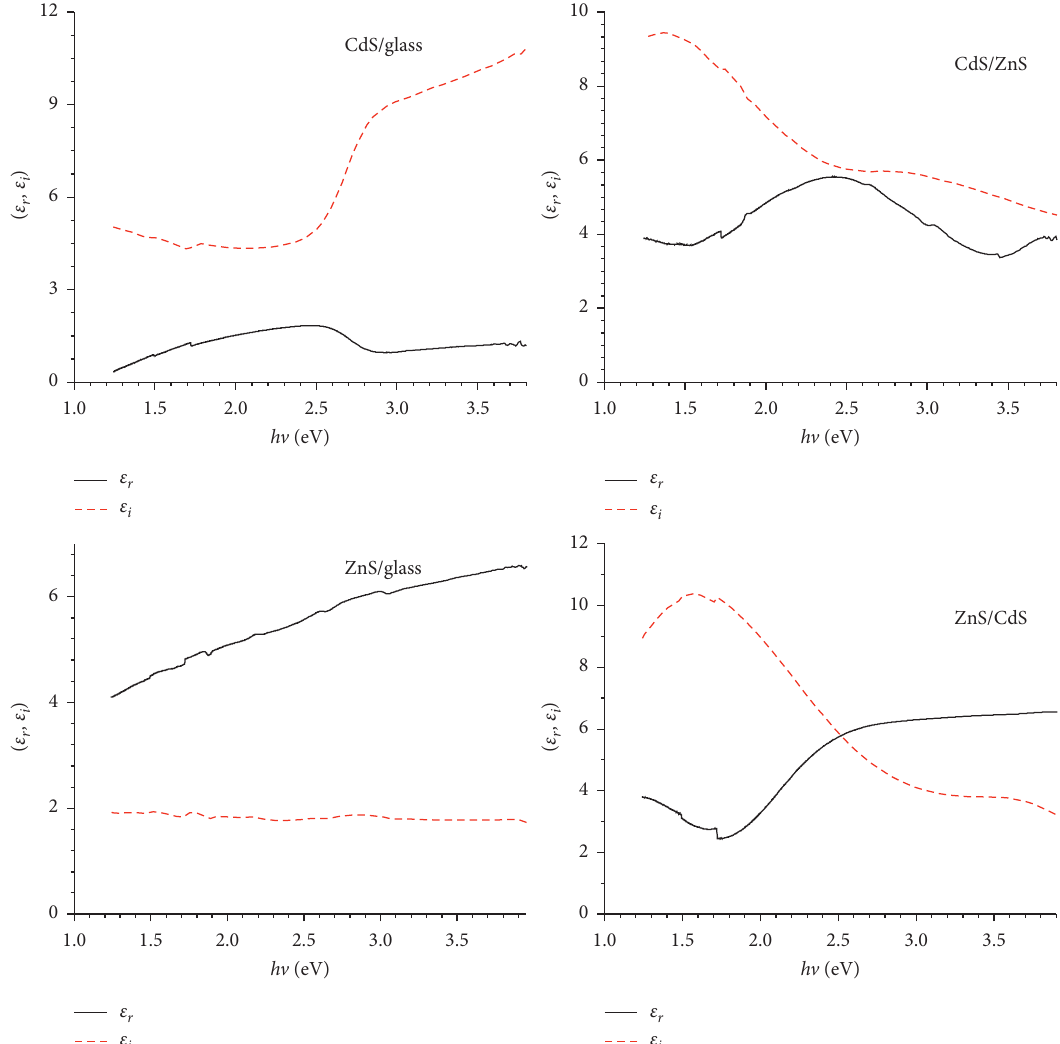
Figure 4: Plots of real ( ε thin films.